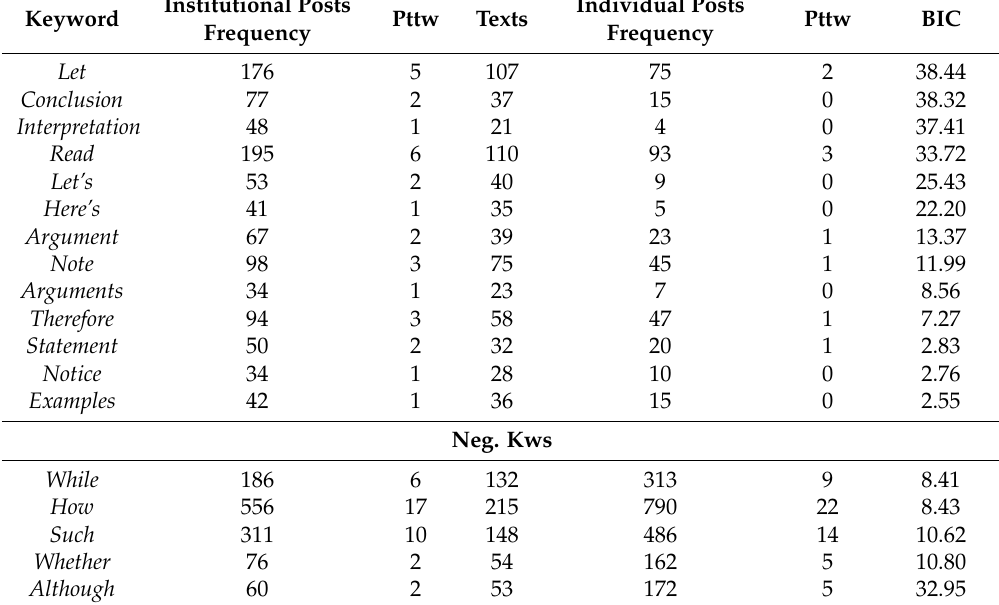
Table 6. Action-oriented dialogicity: individual vs. institutional blog